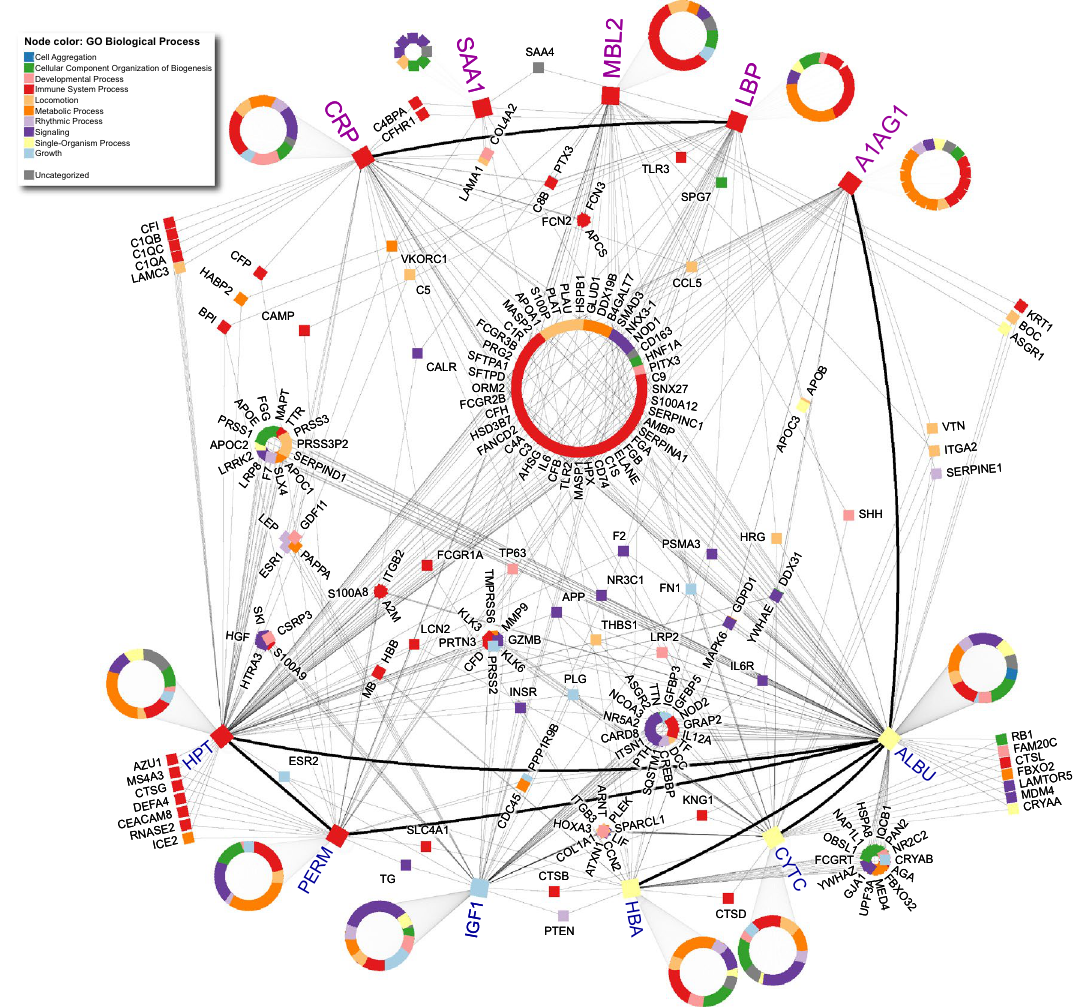
Figure 6. Thirty high connectivity core immune-processing proteins were found according to our PPI Map. The described human protein interactions were analyzed and mapped. A detailed list of 1500 protein interactions can be found in the Supplementary Material